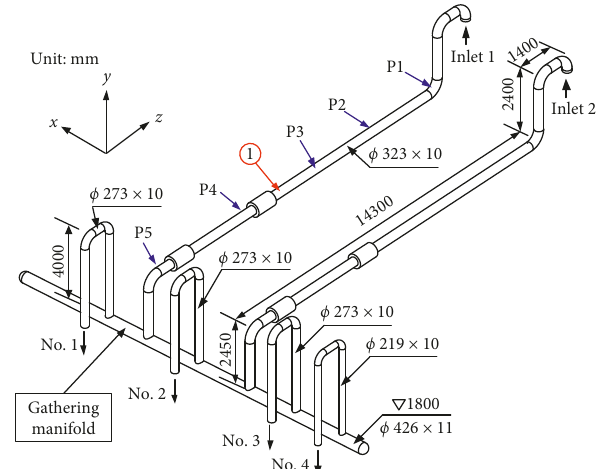
Figure 1: Schematic of the inlet pipelines at a gas compressor station.